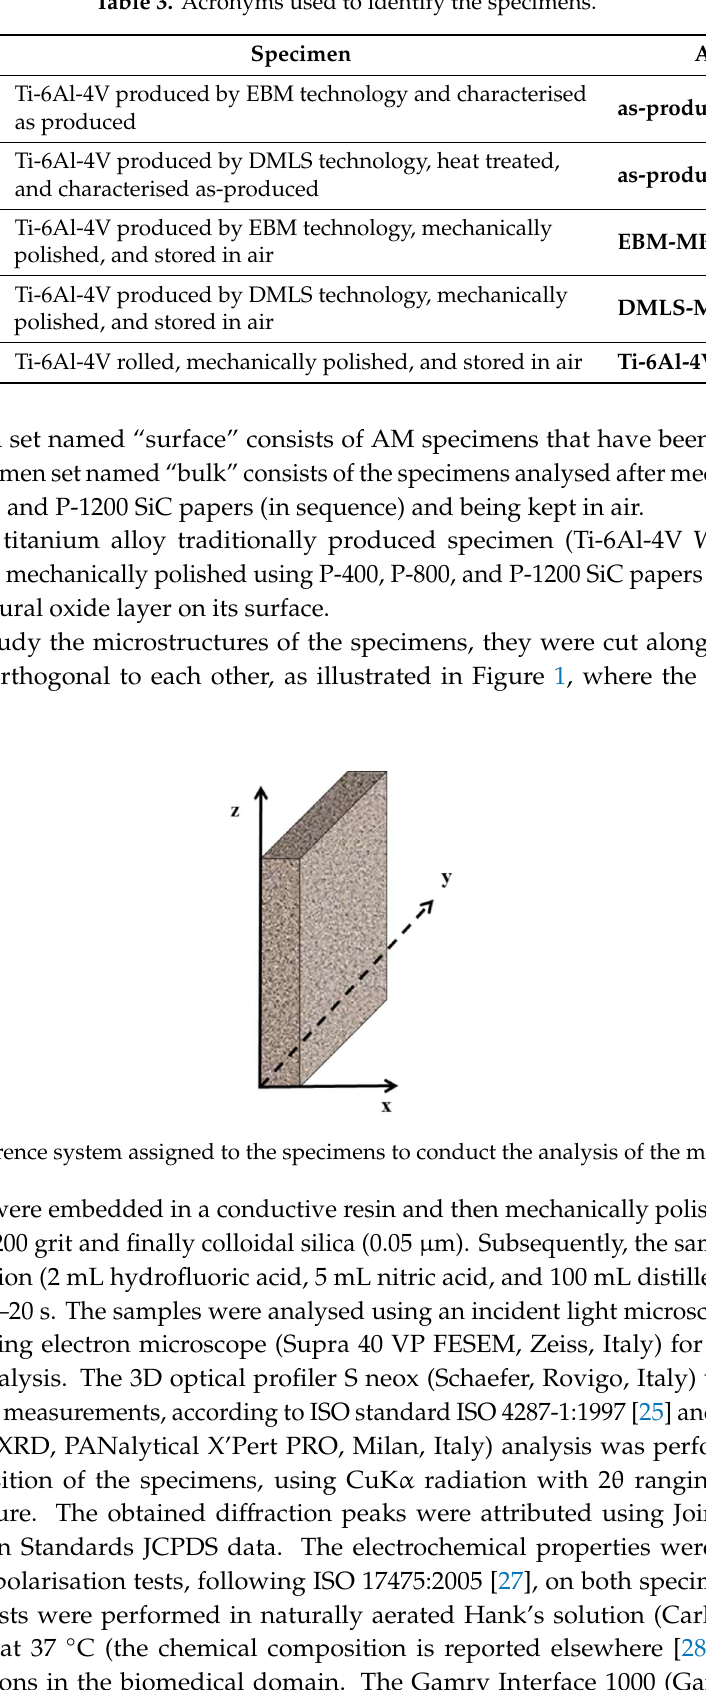
Table 3. Acronyms used to identify the specimens.